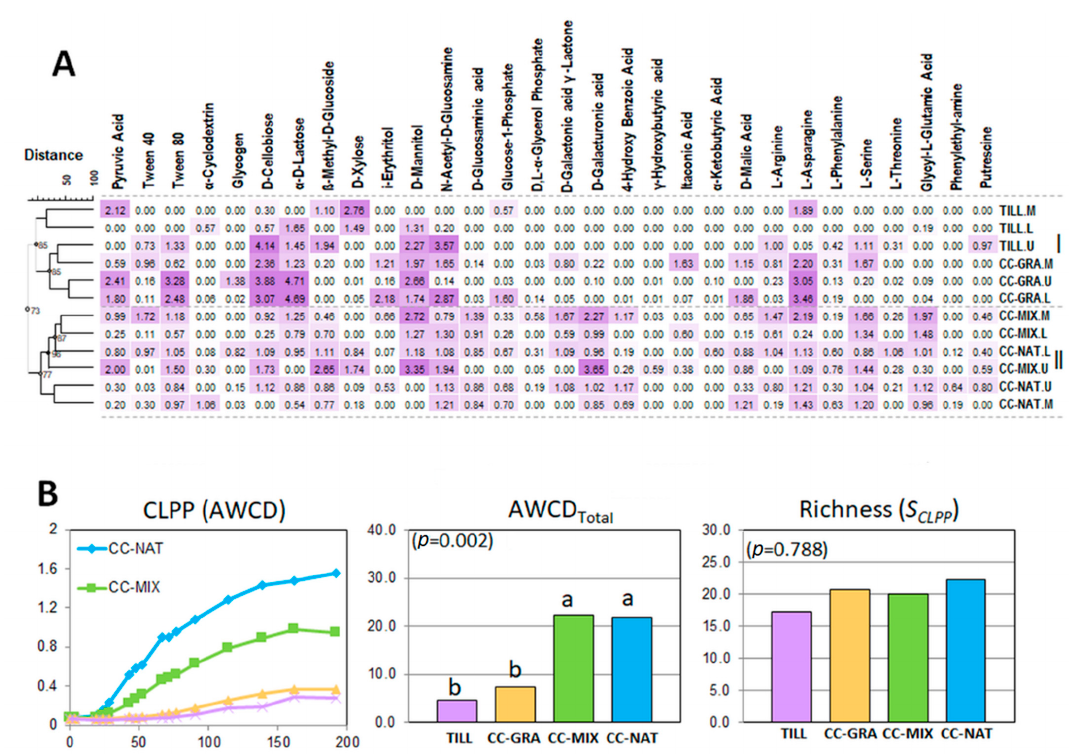
Figure 4. Carbon source assimilation profiles as measured by the Biolog EcoPlate™ of an olive orchard soil under different cover crop managements (TILL: tillage, CC-GRA: sown cover crop with gramineous and CC-MIX: sown cover crop with a mixture of species) and CC-NAT (cover crop with spontaneous vegetation) and for each sampling point on the slope (U: upper, M: middle and L: lower). ( A ) Cluster analysis of combined data using the Ward algorithm applied to the similarity matrix generated from the community level physiological profiles (CLPPs) from absorbance readings at time 192 h by using the Bray–Curtis distance coefficient. Intensity of color in the figure is proportional to activity. Cophenetic correlation values are indicated in each node. ( B ) Kinetics of average well color development (AWCD) during the duration of the experiment and mean comparison of total AWCD (AWCD Total ) and total number of carbon source assimilated profiles at the end of the experiment (Richness, S CLPP ) was performed using the rank-based Kruskal–Wallis test and Dunn’s all-pairwise multiple comparison test was applied when appropriate ( p < 0.05). (Different letters indicate significant differences p < 0.05.)